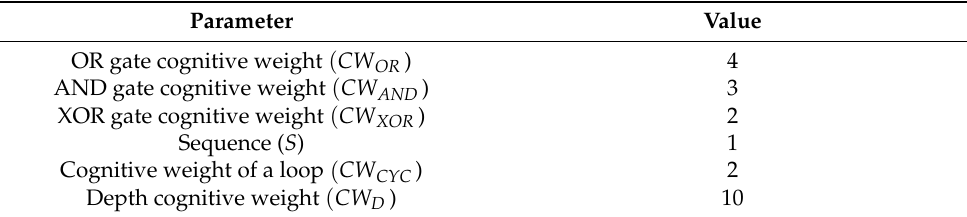
Table 5. Cognitive weights. Parameter Value OR gate cognitive weight ( CW OR ) 4 AND gate cognitive weight ( CW AND ) 3 XOR gate cognitive weight ( CW XOR ) 2 Sequence ( S ) 1 Cognitive weight of a loop ( CW CYC ) 2 Depth cognitive weight ( CW D )